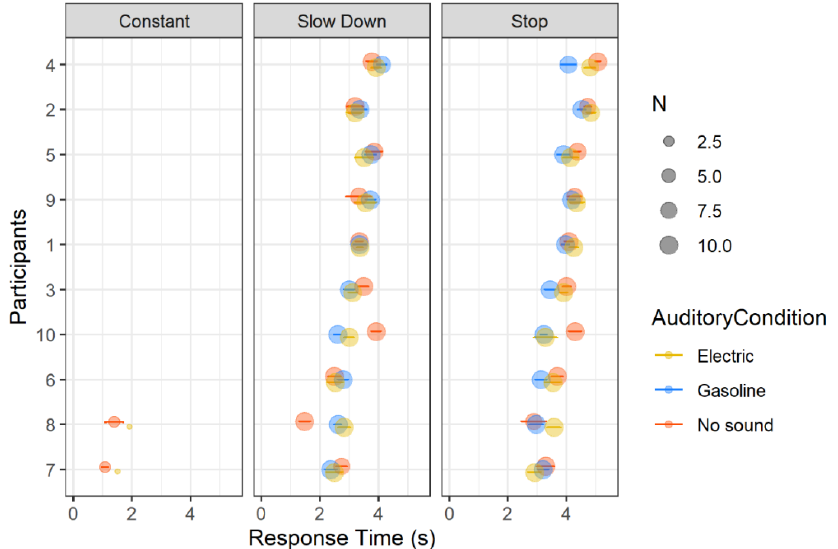
Figure 5. Distribution of the number of crossings (N) with the mean standard error (horizontal lines) of the response time, by the participants, as a function of response time, per speed pattern and auditory condition.